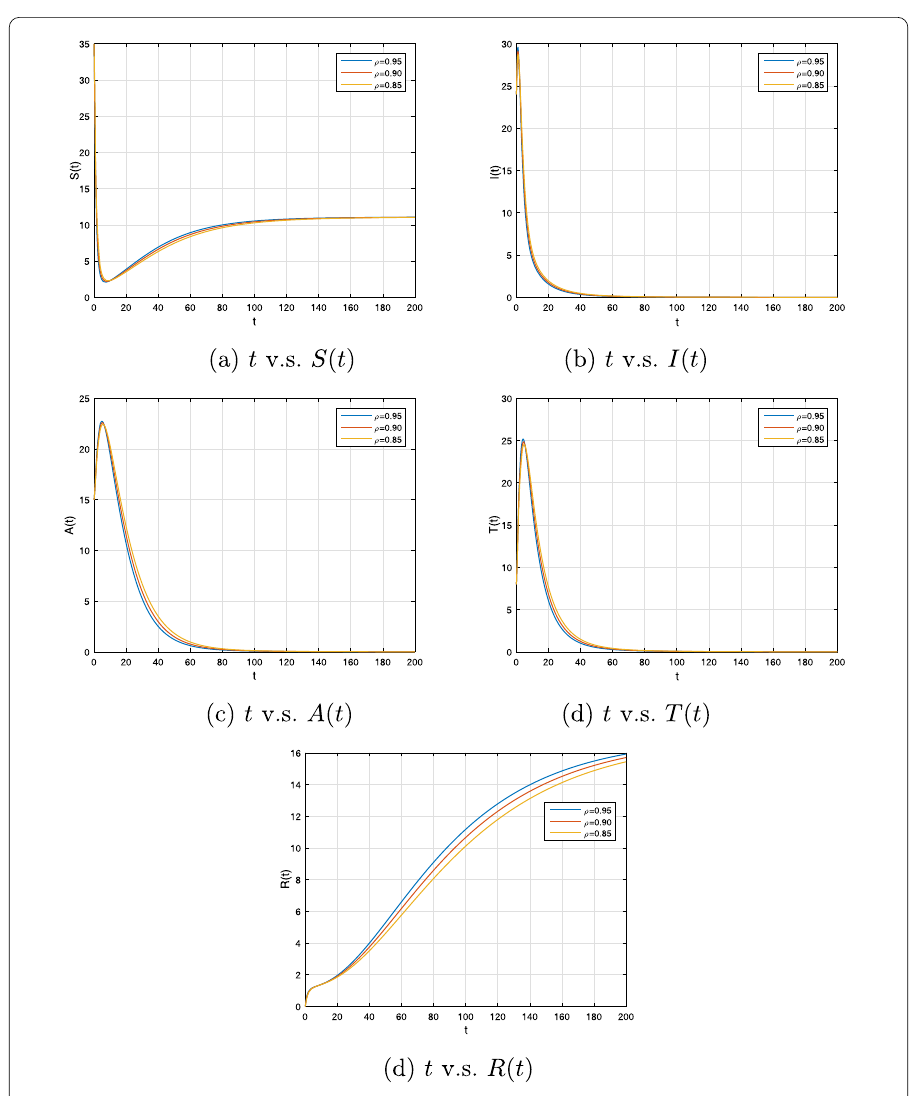
Figure 2 The time series plots for each state variable in model (11) when compared for ρ = 0.95,0.9,0.85 ( a ) t v.s. S ( t ), ( b ) t v.s. I ( t ), ( c ) t v.s. A ( t ), ( d ) t v.s. T ( t ), ( e ) t v.s. R ( t )